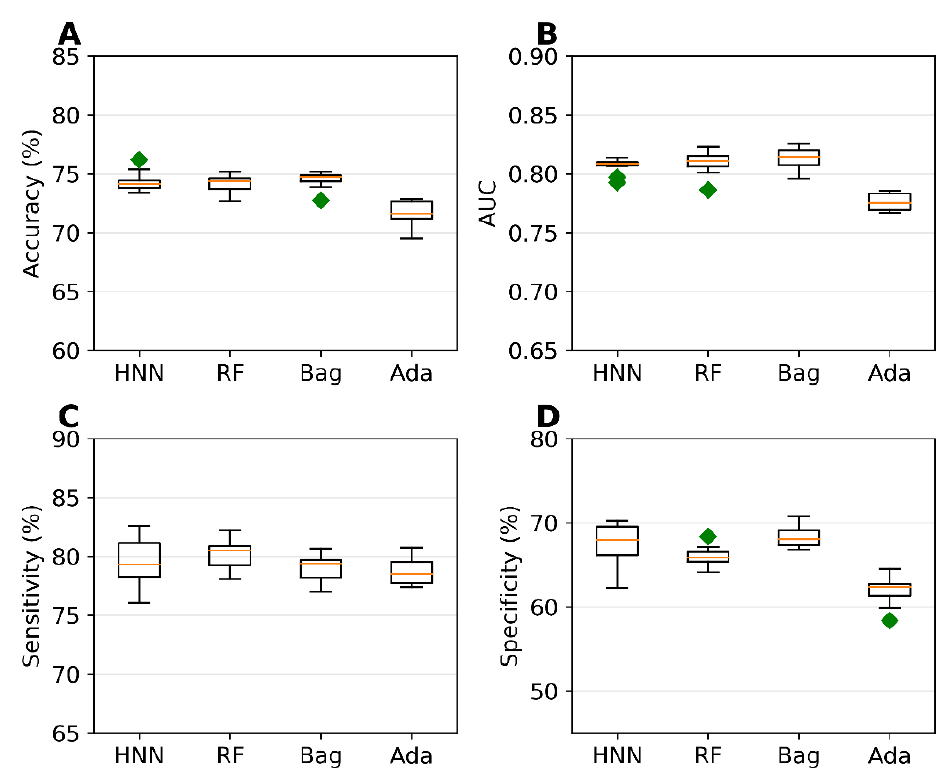
Figure 1. ( A ) accuracy, ( B ) AUC, ( C ) sensitivity, and ( D ) specificity for the dataset I as given by the binary classification models developed based on the HNN, RF, Bagging, and AdaBoost methods. Zhang et al. [10] built several machine learning models on the CPDB’s 1003 carcino- genic data on rats. The highest accuracy they reported was 70.1%, and an AUC of 0.765 for the five-fold cross-validation. Wang et al. [13] developed a deep learning tool Cap- sCarcino on the 1003 rat data from CPDB used by Zhang et al. For five-fold cross-